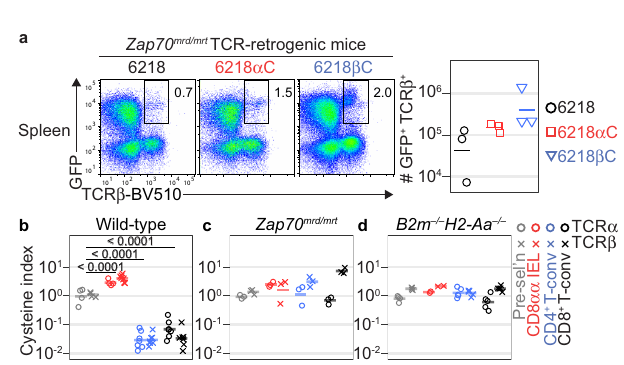
Fig. 3 | Role of Zap70 and MHC in cysteine-linked T cell fate skewing. a Attenuation of TCR signaling disrupts the effect of a Cys-containing CDR3 on T cell fate. BM cells pooled from Zap70 mrd/mrt mice (11 female and 9 male; aged 33-60 d) were transduced with retroviruses encoding GFP and the 6218, 6218 α C or 6218 β C TCR and then injected into irradiated male Zap70 mrd/mrt mice. TCR- retrogenic mice were analysed on day 36 or 41 after transplantation ( n =3/group). Plots show splenocytes analysed for GFP/TCR β phenotype with a gate for GFP + TCR β + cells. Graph shows the absolute number of GFP + TCR β + splenocytes with each symbol representing one mouse. b – d Differential Cys-containing CDR3 expressioninpolyclonalTcellsubsetsrequiresstrongTCRsignalinginresponseto pMHCligands.Sortedpre-selectionthymocytes,smallintestinalCD8 αα IEL,splenic CD4 + T-conv and splenic CD8 + T-conv populations were analysed by TCR sequen- cing. Graphs show the percentage of unique TCR α (circles) or TCR β (crosses) sequences with Cys within 2 positions of the middle CDR3 amino acid (cysteine index)witheachsymbolonagraphrepresentingasamplefromonemouse. b Some of the data from wild-type mice has been published 30 and is included here for comparison ( n =11; 6 females and 5 males, aged 45-113 d); c Data for Zap70 mrd/mrt mice (n=3 males aged 37 – 74 d). d Data for B2m – / – H2-Aa – / – mice ( n =1 female and 4 males aged 98 – 140 d). P values in b were determined using 2-way ANOVA with Sidak ’ s multiple comparisons test. Source data are provided as a Source Data fi